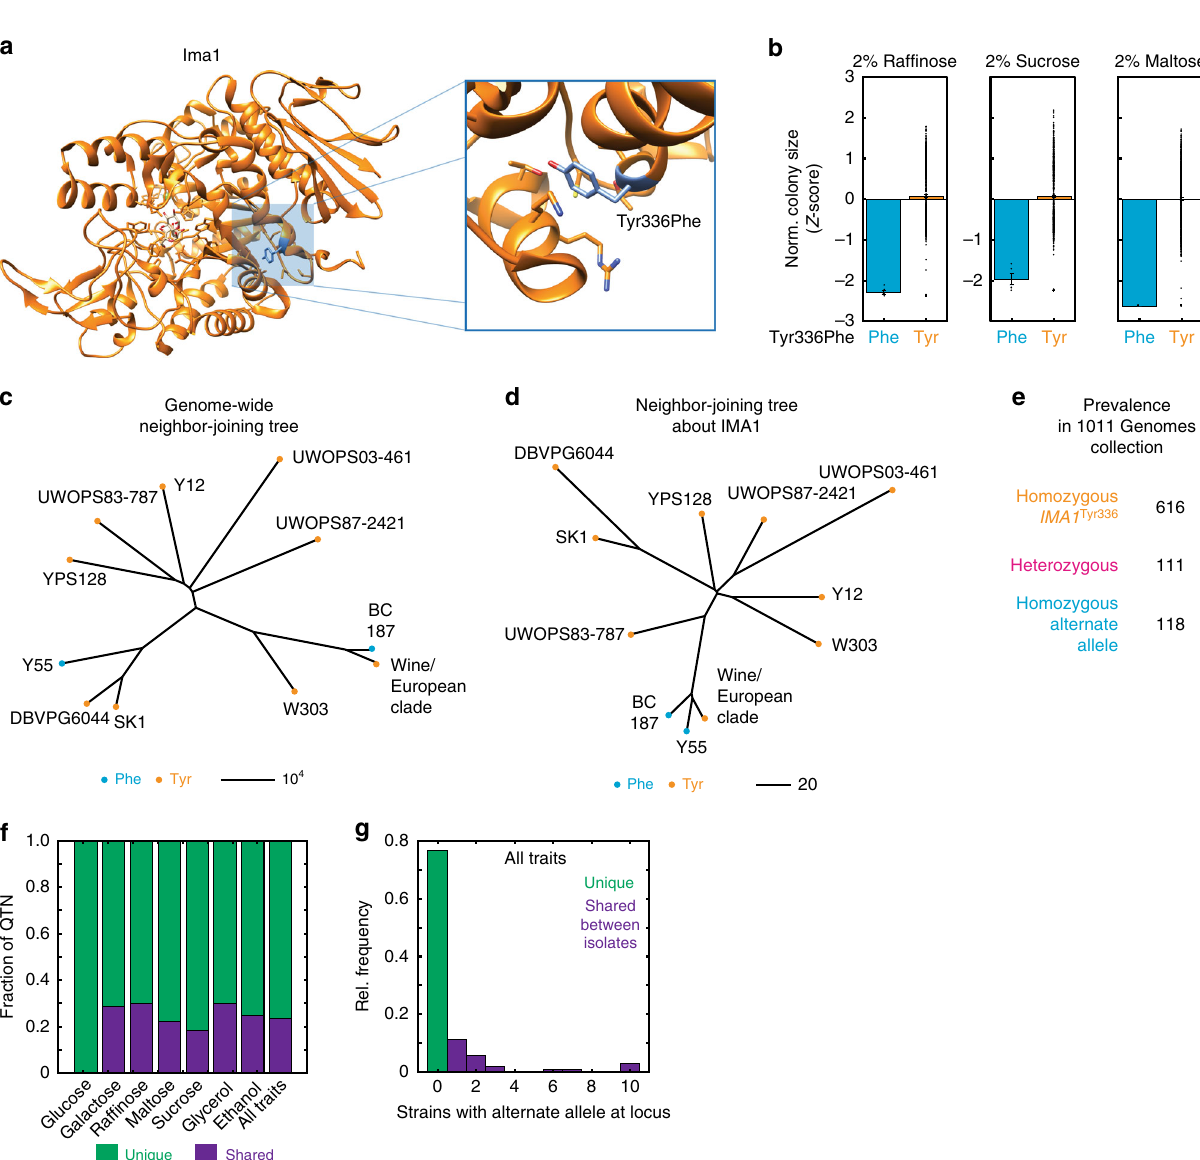
Fig. 4 Prevalence of IMA1 Tyr336Phe and other QTNs across S. cerevisiae . a Crystal structure of Ima1 in complex with isomaltose; highlighted is the Tyr336 residue that is mutated to Phe (PDB ID: 3AXH). b Growth phenotypes of segregants with Phe336 (blue) and Tyr336 (orange) in raf fi nose, sucrose, and maltose. Data shown are normalized, Z -scored colony size for each allele; bars show the mean. c Phylogeny of the IMA1 Tyr336Phe variant across the SGRP collection; the neighbor-joining tree is constructed on the basis of all segregating polymorphisms. d Phylogeny of the IMA1 Tyr336Phe variant across the SGRP collection; the neighbor-joining tree is constructed on the basis of only the segregating polymorphisms within 250 variants of the IMA1 variant on the genome. Scale bars show neighbor-joining distance. e Prevalence of the IMA1 variant shown in ( a ) across 1011 sequenced S. cerevisiae isolates 28 . f Fraction of QTN that are unique to RM11 or YJM975 (singletons; green) or shared with another SGRP isolate (purple), for each growth condition tested. g Histogram of the number of strains within the SGRP collection bearing the alternate allele at each locus identi fi ed as a QTN. Source data are provided as